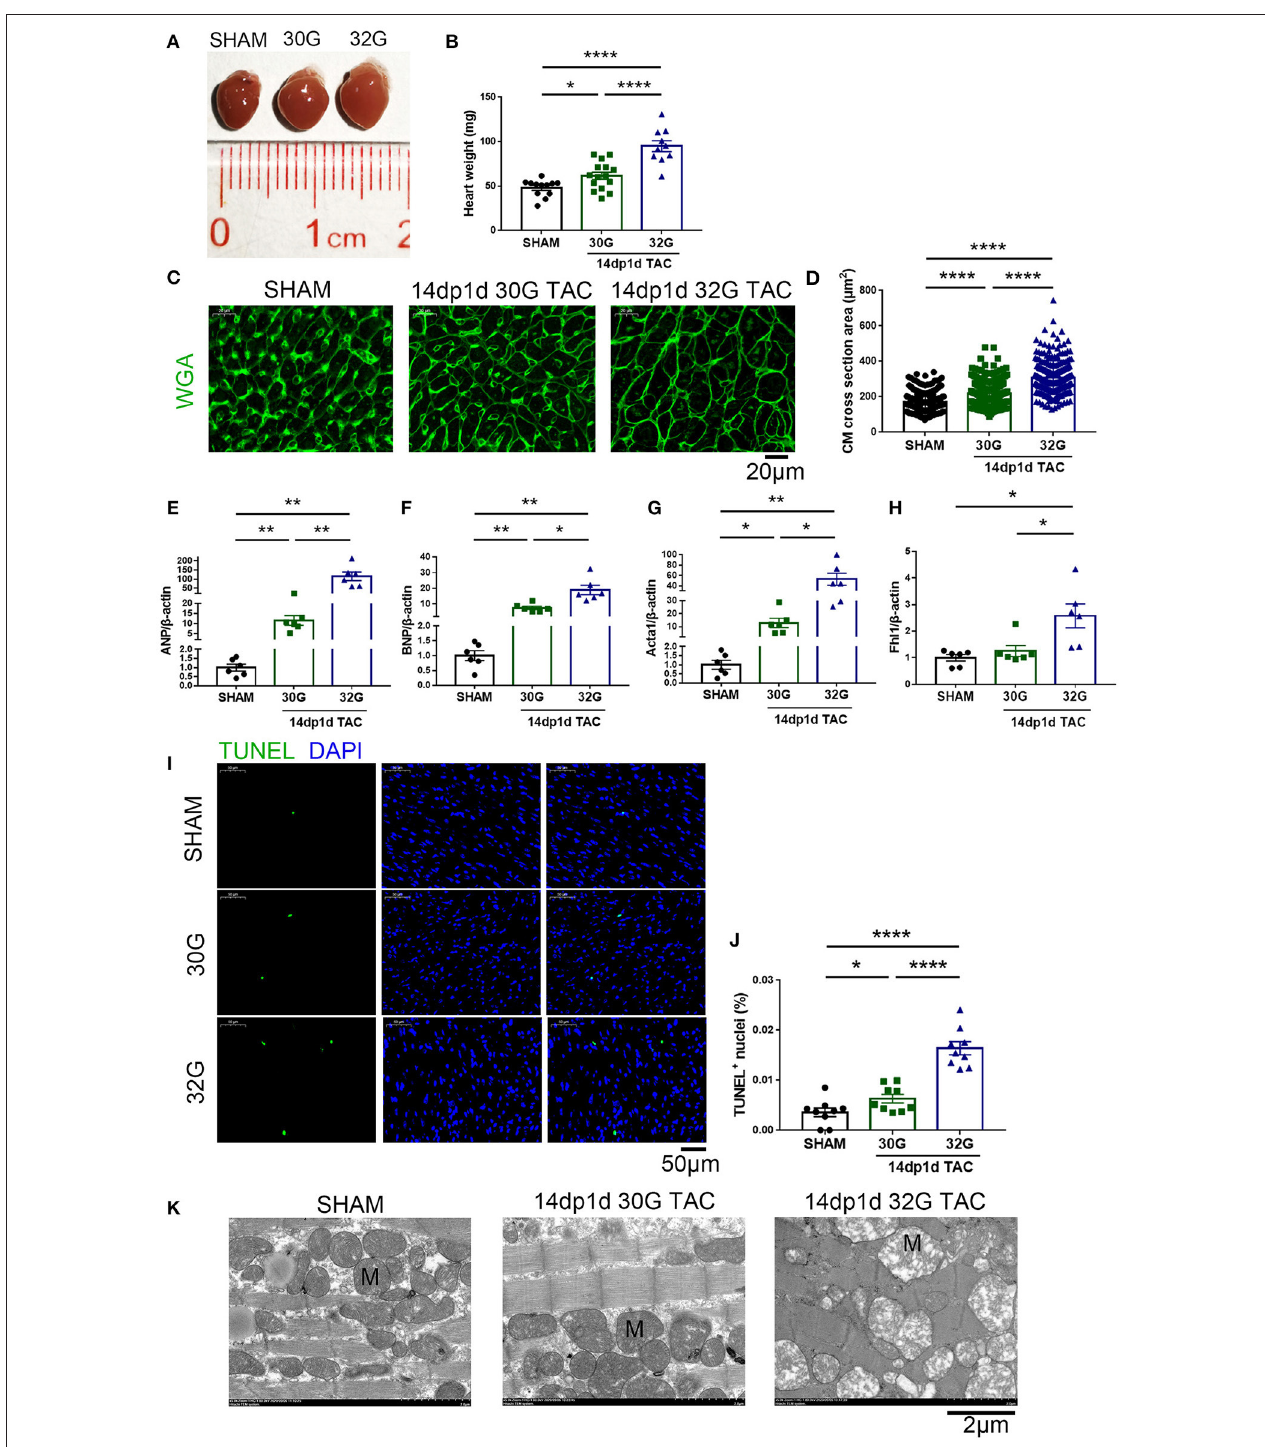
FIGURE 6 | Apoptosis and hypertrophy increased in mice 14 days after the 30G and 32G TAC. (A) Hearts of mice in the sham (left), 30G TAC (middle), and 32G TAC (right) groups. (B) The heart weight analysis in the three groups: n = 12, sham; n = 15, 30G TAC; n = 10, 32G TAC. (C) Representative heart sections stained with WGA (green) in the three groups. Scale bar: 20 µ m. (D) Analysis of cardiomyocyte cross-sectional area in the three groups; n = 3 hearts per group. A total of 300 cardiomyocytes per group were analyzed. (E–H) Expression of ANP, brain natriuretic peptide (BNP), Acta1 and four and a half LIM domains 1 (Fhl1) in the ventricular tissue; n = 6, sham; n = 6, 30G TAC; n = 6, 32G TAC. (I) Representative images of TUNEL-positive cells from heart sections in the three groups. Scale bar: 50 µ m.